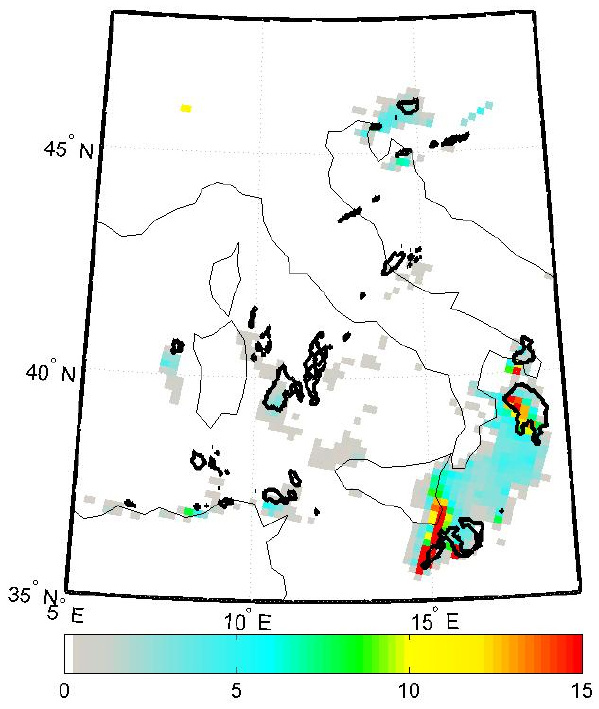
Fig. 2. Instantaneous rainfall rates (color scale in mmh − 1 ) retrieved from an AMSU overpass on 2 October 2009, 01:24 (same as right panel of Fig. 1), and corresponding HPNA high-precipitation areas (black contours).